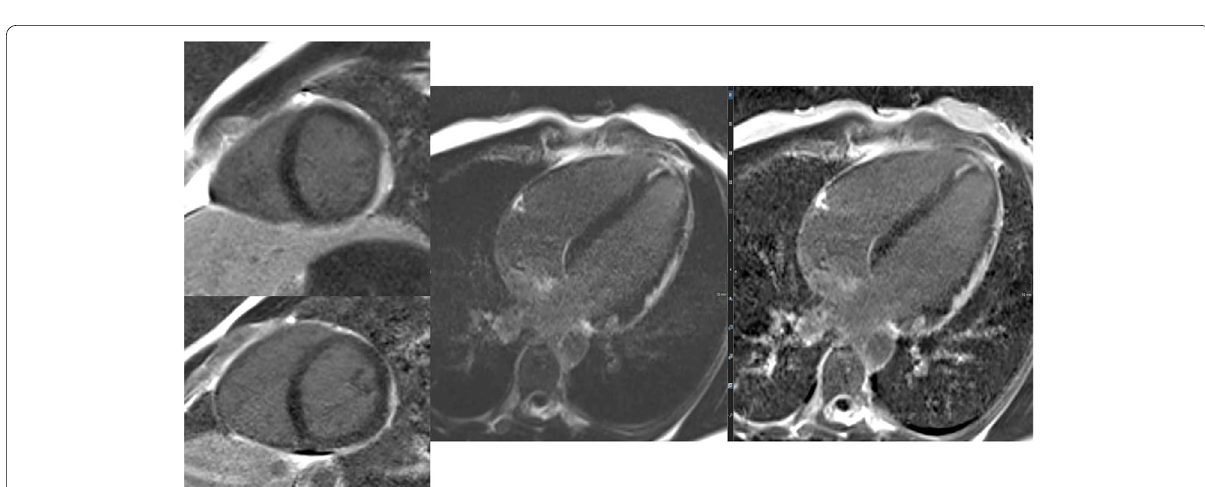
Fig. 14 (LGE imaging): SAX (left upper and lower row) and 4-chamber view in IR (middle) and PS (right) reconstructions show an increased subepicardial signal of the left lateral wall, partly including mid-wall parts of the LV